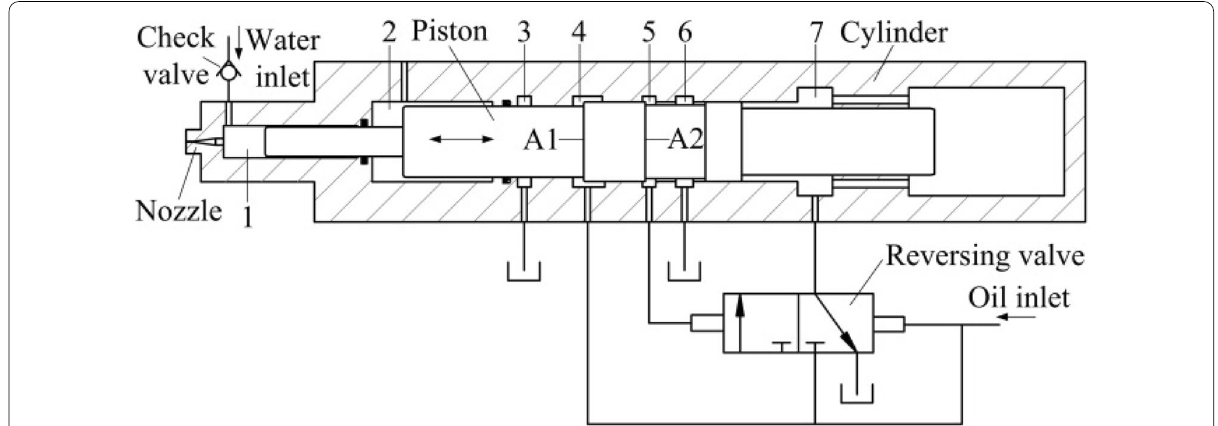
Figure 2 SSPWJ generation